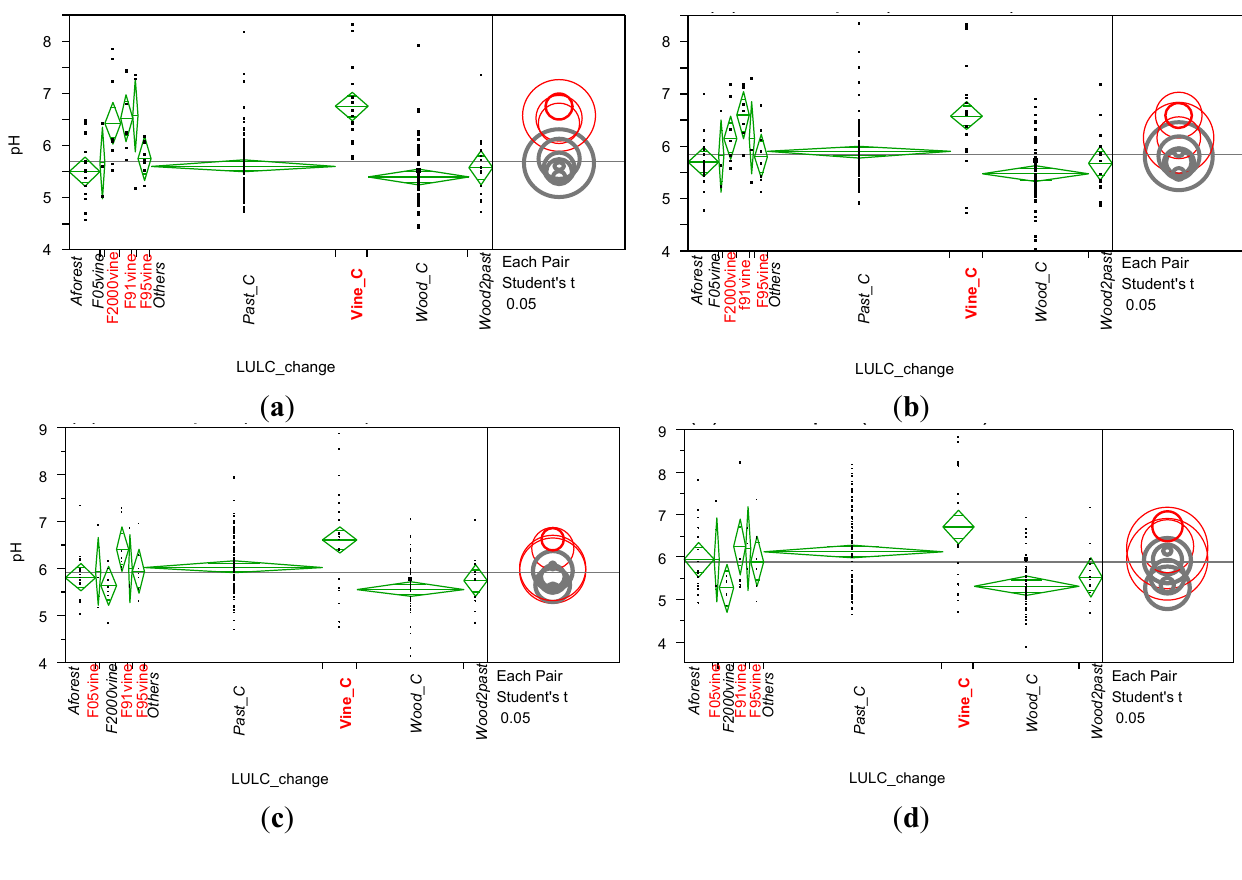
Figure 2. Diamond plots of analysis of variance of soil pH at different depths. Note that the circles on the right indicate pairwise comparison; the highlighted Vine_C (thick red circle) is not significantly different from other red circles, but significantly different from thick gray circles. See Table 1 for explanation of abbreviations. ( a ) Soil depth (0–10 cm); ( b ) soil depth (10–20 cm); ( c ) soil depth (20–30 cm); ( d ) soil depth (40–50